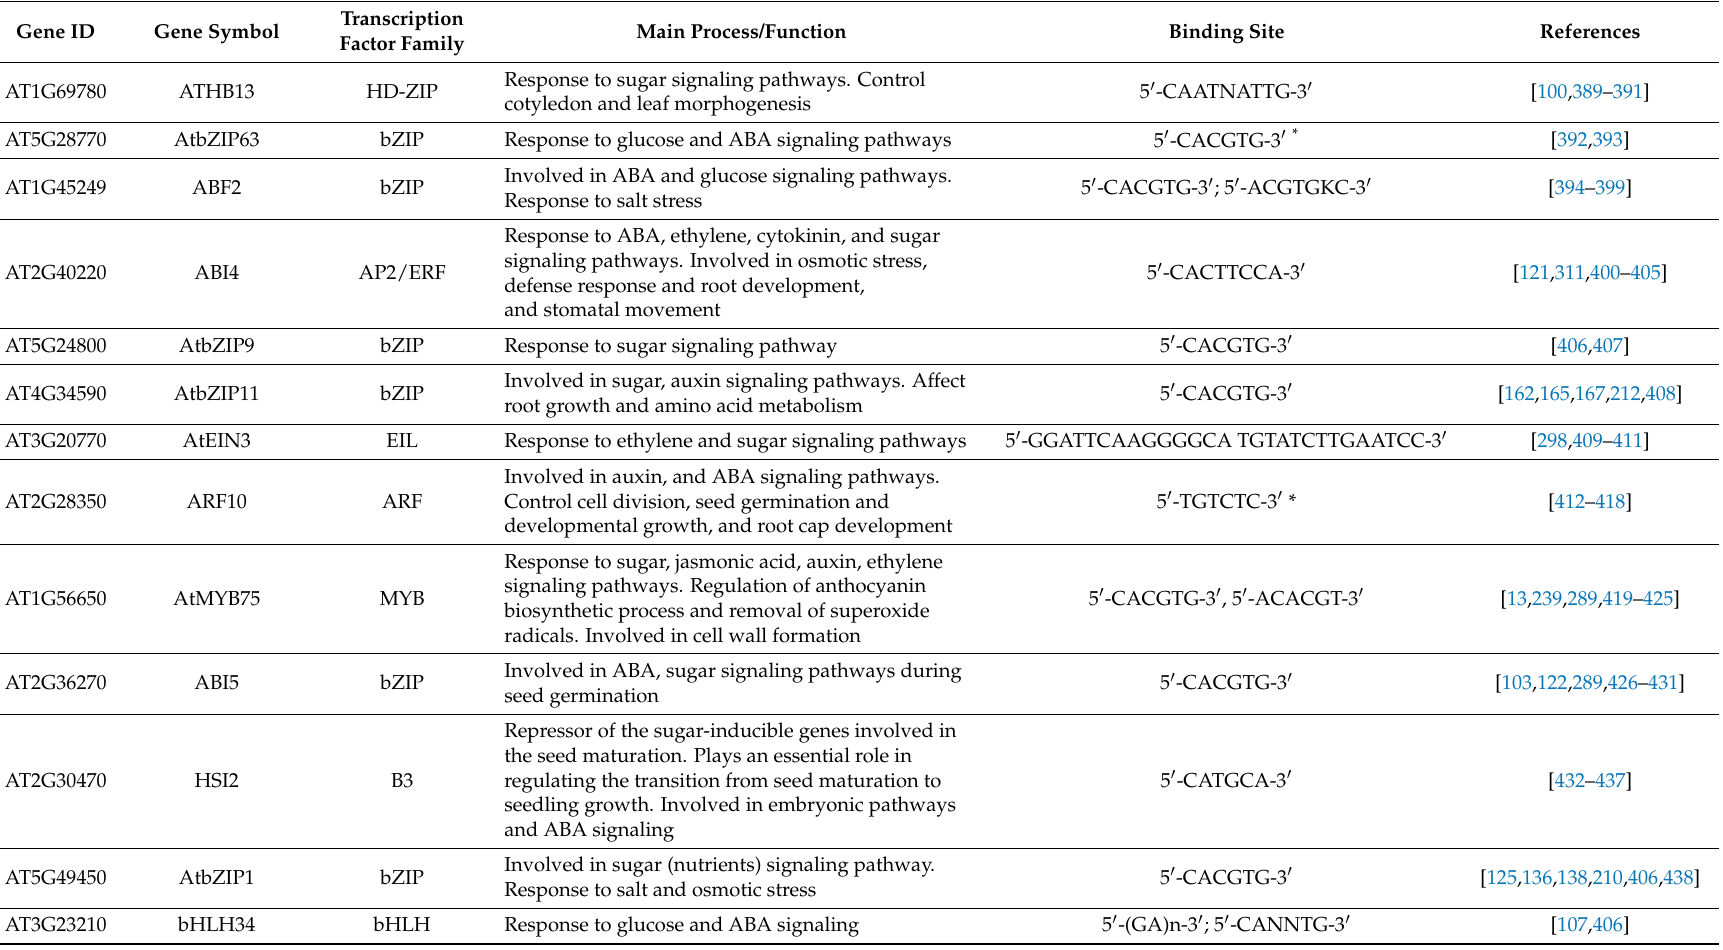
Table 1. The transcription factors that are involved in sugar signaling in Arabidopsis